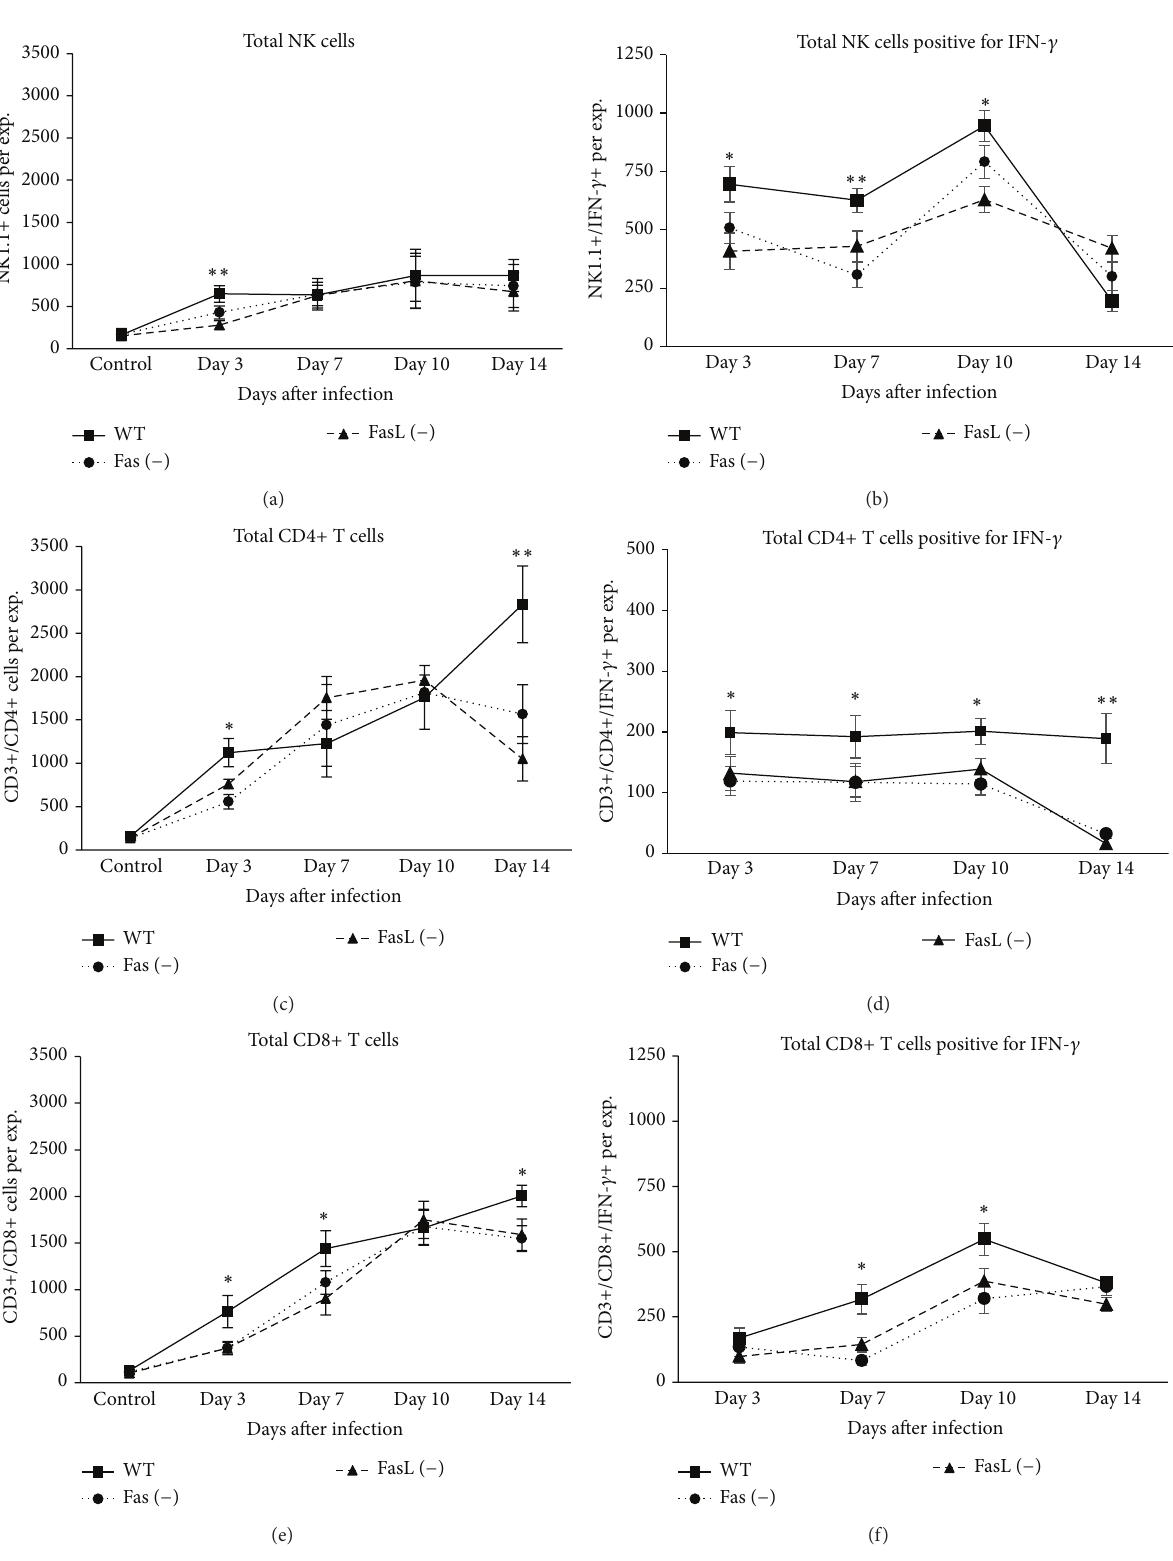
Figure 3: Lack of Fas or FasL leads to disturbances in antiviral immune response. Total counts of NK cells (a) NK/IFN- 𝛾 + cells (b), CD4+ T cells (c), CD4+/IFN- 𝛾 + T cells (d), CD8+ T cells (e), and CD8+/IFN- 𝛾 + T cells (f) in cell suspensions prepared from the lungs isolated from Fas ( − ), FasL ( − ), and WT (C57BL/6) mice at 3, 7, 10, and 14 days of ECTV infection and from control, uninfected mice. The bars represent the mean from 5 separate experiments ± SEM. ∗ Significant differences with 𝑃 ≤ 0.05 and ∗∗ 𝑃 ≤ 0.01 in comparison to Fas- and FasL-deficient